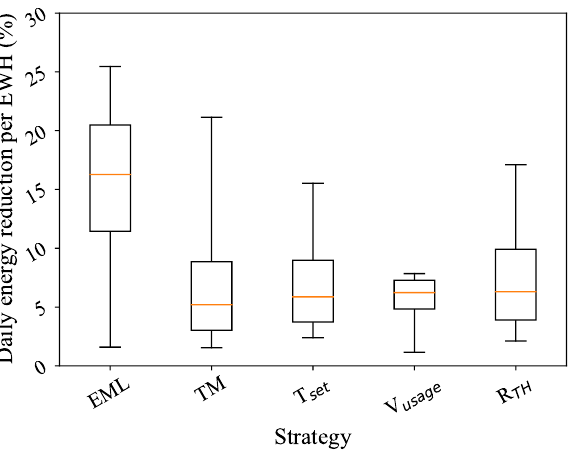
Figure 2. Box plot showing the distribution of the daily reduction in energy consumed (as a percent- age) by each EWH compared to that produced by the baseline energy consumption for T set (set to 60 °C), V usage (10% reduction), and R TH (thermal blankets and pipe